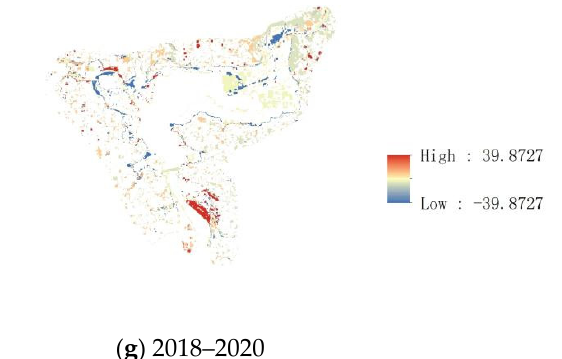
Figure 4. Spatial distribution map of two adjacent interphase carbon stock changes in the coastal zone of Qinglan Bay in Hainan Province from 1988 to 2020.